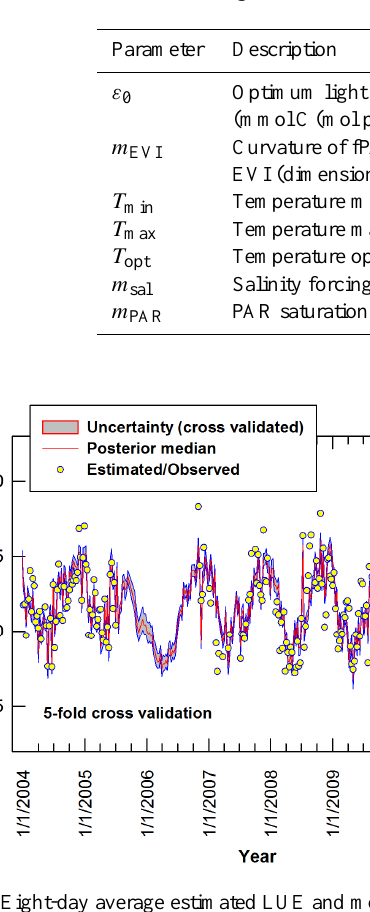
Table 1. MVP-LUE model forcing terms and associated uncertainty bounds.